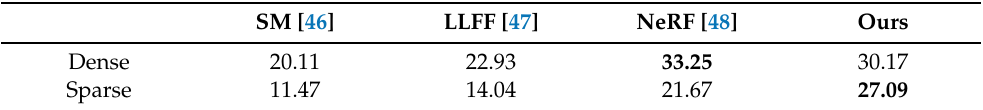
Table 3. Quantitative evaluation of the synthesized images in terms of peak signal-to-noise ratio (PSNR) (dB).